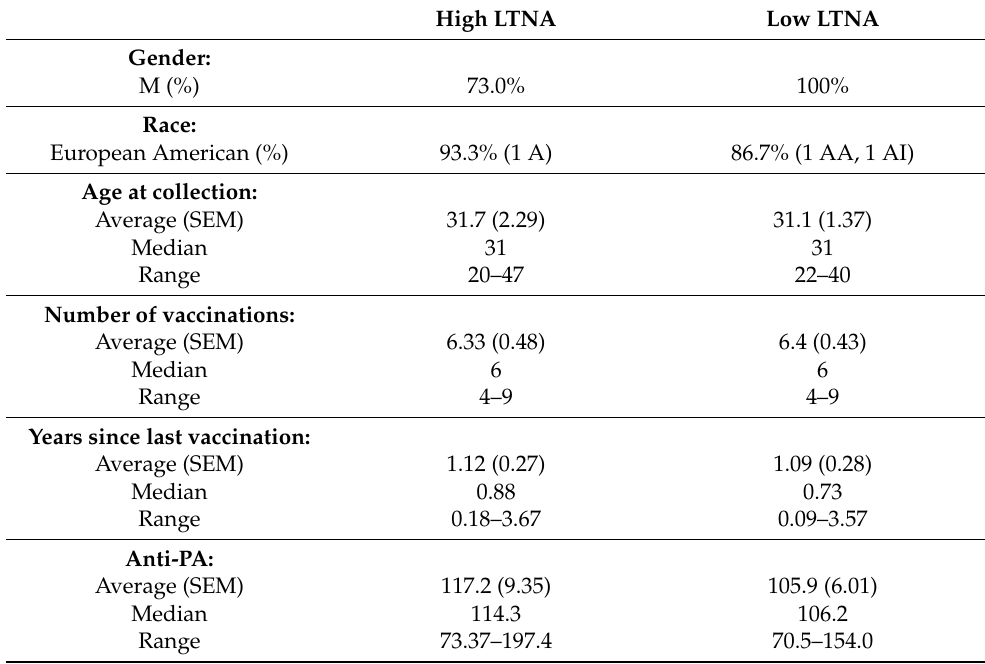
Table 1. Demographics and vaccination information summary of 15 high and 15 low neutralizers. For gender M refers to male; for race A refers to Asian, AA to African American, and AI to American Indian. Anti-PA values are in µ g/mL. High